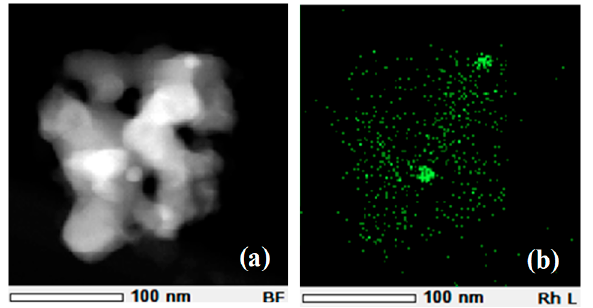
Figure 1. ( a ) Ex situ tunneling electron microscopy (TEM) image and ( b ) EDS mapping of engine-aged catalyst.